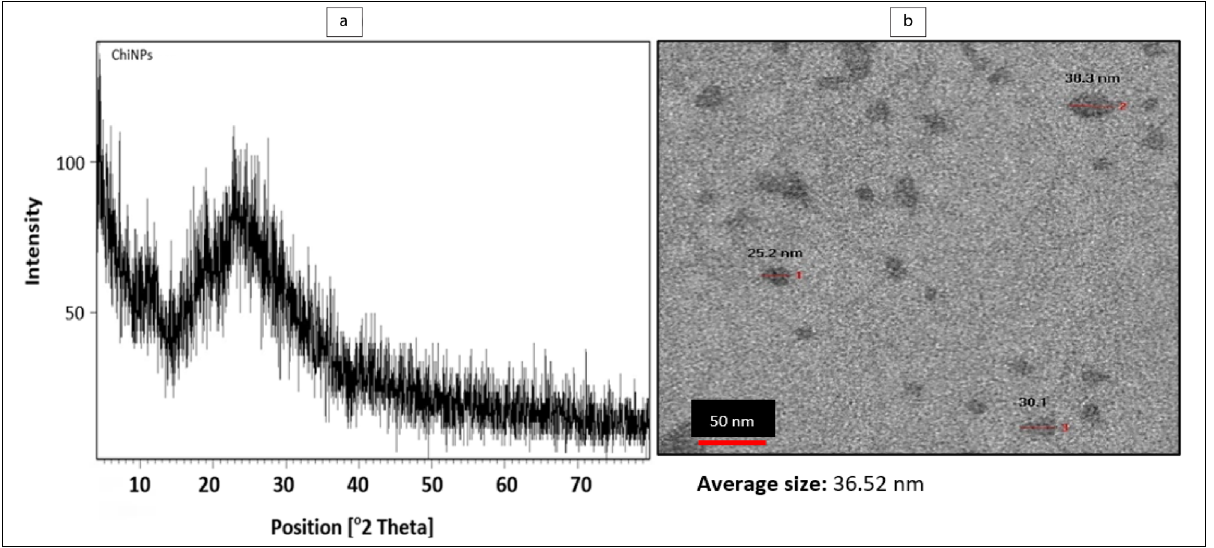
Figure 3: (a) X-ray diffraction pattern displaying amorphism nature of chitosan nanoparticles with the formation of a hump shape from 10 to 30 2 θ angle. (b) Transmission electron micrograph illustrating the pseudospherical to spherical shape of chitosan nanoparticles (ChiNPs) with an average size of 36.52